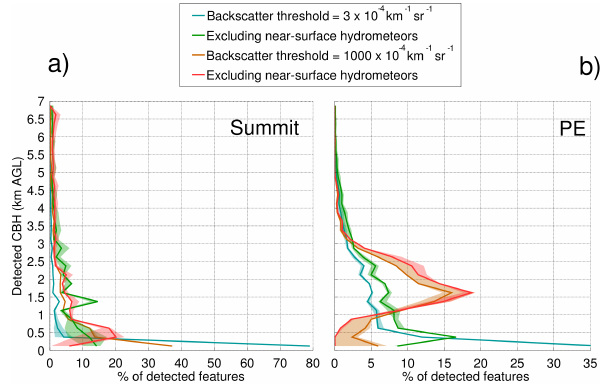
Fig. 11. PT CBH occurrence (%) for low (3 × 10 − 4 km − 1 sr − 1 , blue curves) and high (1000 × 10 − 4 km − 1 sr − 1 , brown curves) thresh- olds. Also shown is CBH occurrence after removing profiles af- fected by hydrometeors in the first 60m (green and red curves). Un- certainty of the results due to SNR-threshold choice is indicated by the shaded areas. (a) Analysis for Summit (2010–2012). (b) Analy- sis for PE, with data limited to summer months